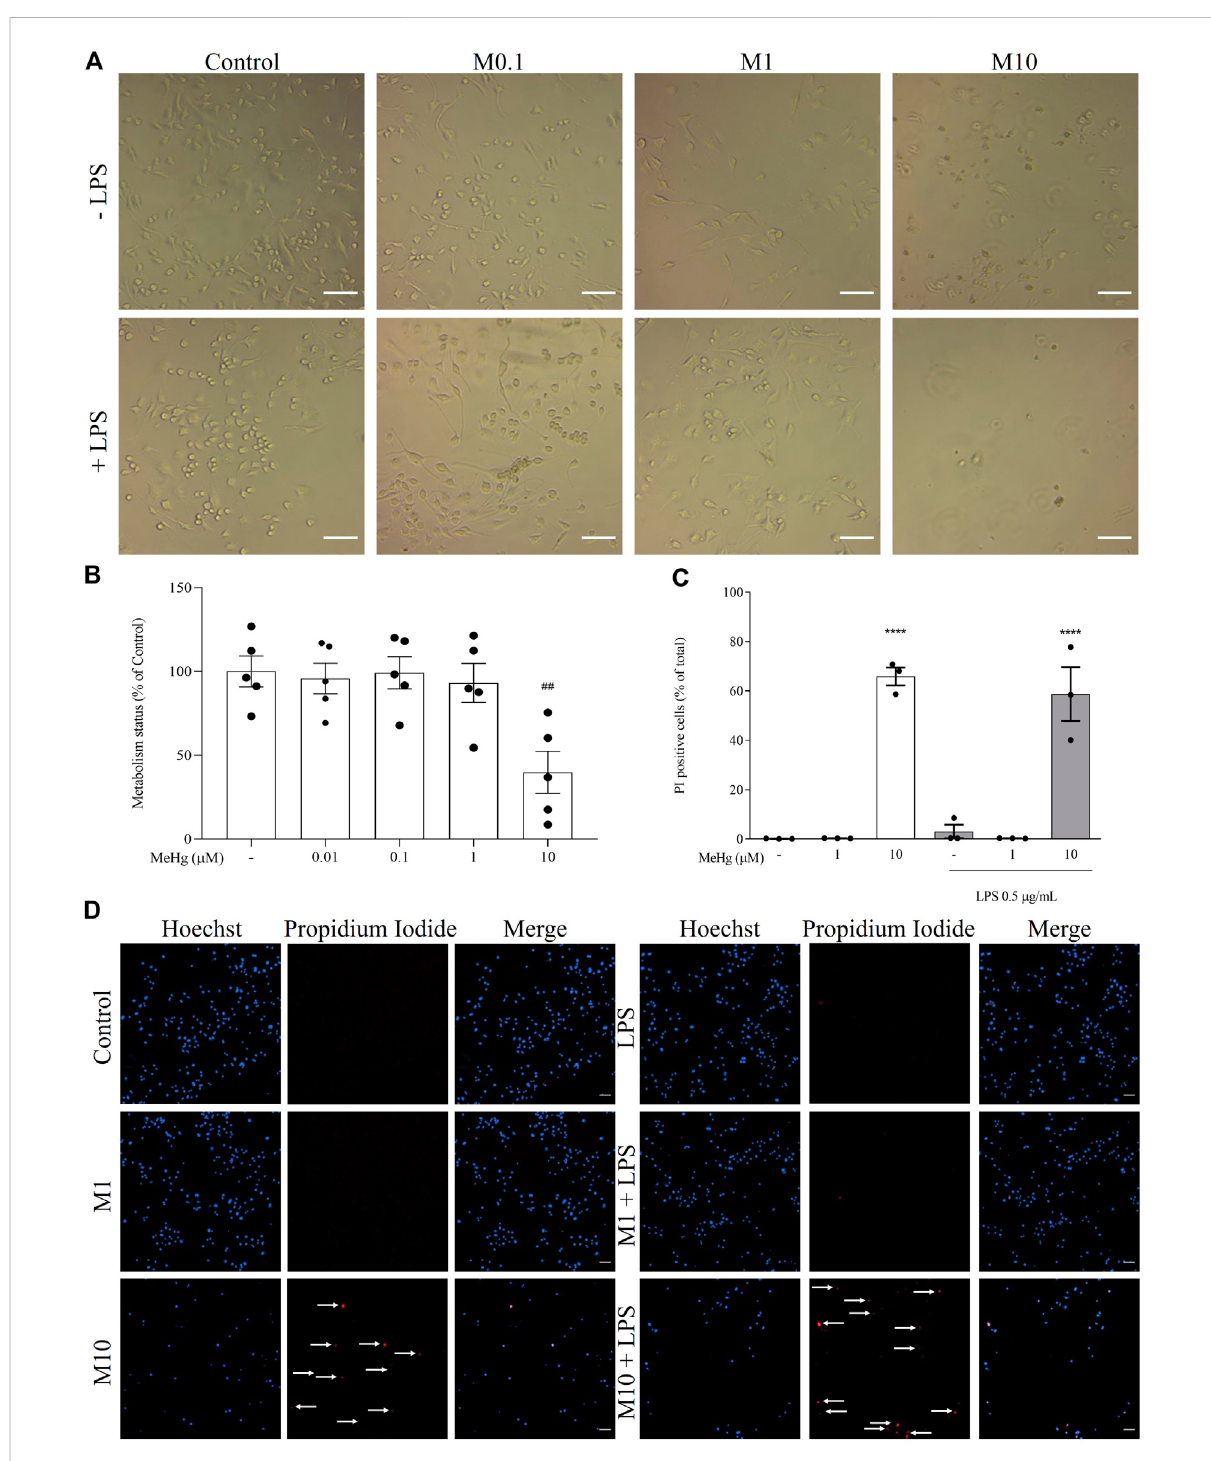
FIGURE 4 Effect of MeHg exposure (0.01, 0.1, 1, and 10 µM) on the metabolic activity and cell death by necrosis. (A) Representative images of cellular viability. Scale bars, 100 µm. (B) Assessment of the metabolism status of cells and (C) quanti fi cation of PI-positive cells after exposure to different MeHg concentrations on BV-2 microglial cell treated for 1 h subsequently stimulated with LPS for 6 h. (D) Representative images of Hoechst 33342 (blue)andPI-positive (red)labelledcells.ArrowsshowPI-positivecells. Scalebar,200 μ m## p < 0.01and#### p < 0.0001vs.Control;**** p < 0.0001 vs. LPS. Data are expressed as Mean ± SEM, n = 3. One-way ANOVA, followed by Bonferroni ’ s multiple comparisons